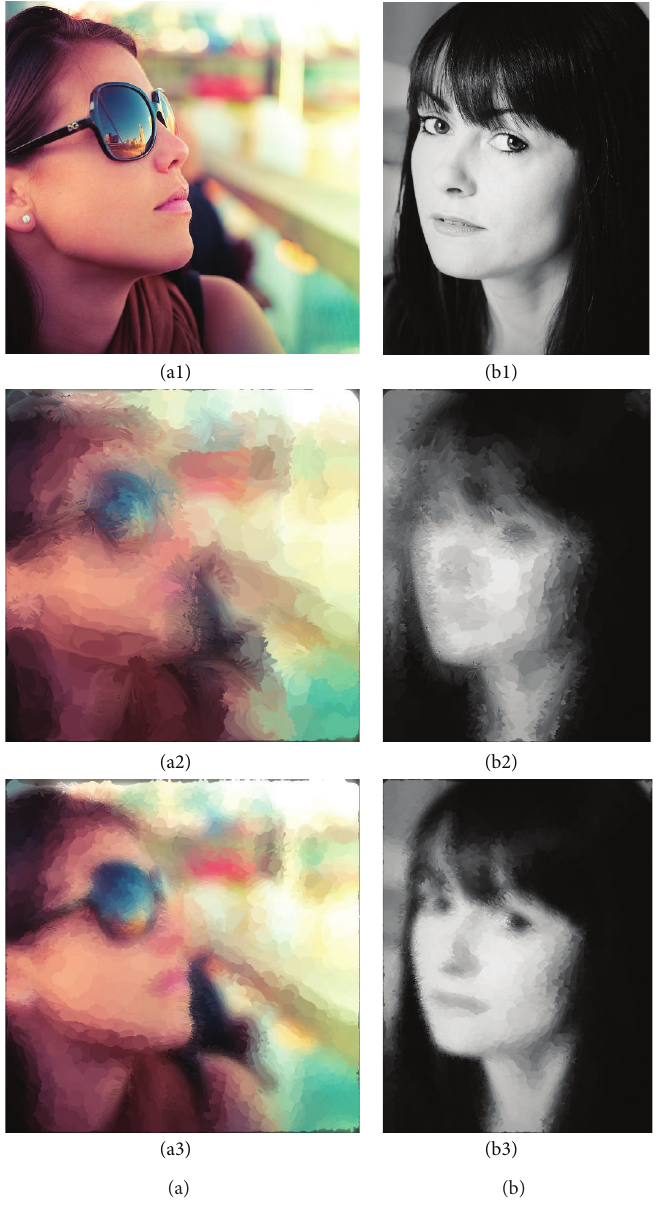
Figure 5: Two portrait images’ Pointillisms. 𝑁 = 40000 (a) and 𝑁 = 39000 (b). ((a1), (b1)) Source image with size: 1024×1024 and 768×1024 ; ((a2), (a3)) with maximal/minimal dot size: 103/11 and 51/5; ((b2), (b3)) with maximal/minimal dot size: 77/9 and 39/5.